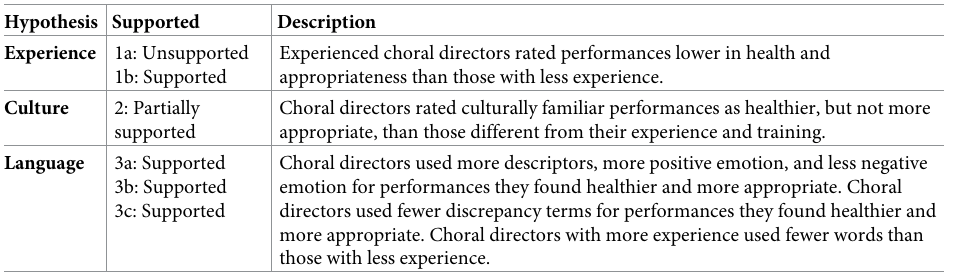
Table 8. Summary of expectations and